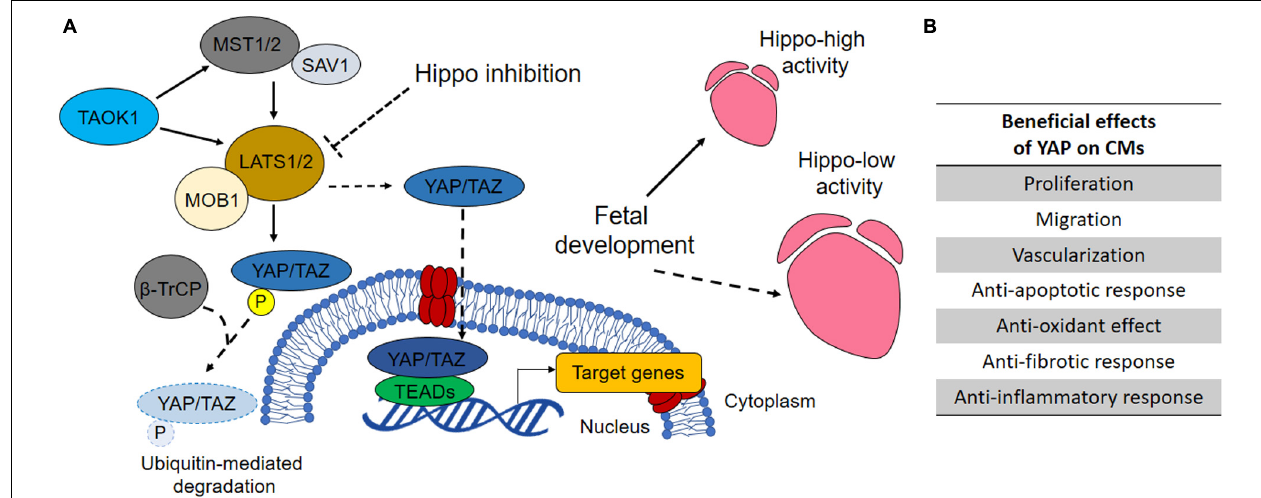
FIGURE 2 | The role of Hippo pathway in heart development and homeostasis. (A) When Hippo pathway is on, the mammalian MST1/2 (STE20-like protein kinase 1/2) and SAV1 (protein salvador homolog 1) complex activates LATS1/2 (large tumor suppressor homolog 1/2) that phosphorylates, in association with MOB1 (MOB kinase activator 1), YAP (Yes-associated protein 1) and TAZ (WW domain-containing transcription regulator protein 1), thus promoting their degradation. Conversely, when Hippo signaling is off, YAP and TAZ shuttle into the nucleus where they bind TEADs (TEA domain transcription factor family members) and regulate the transcription of genes involved in cell proliferation, survival and migration (Henry et al., 2001). By regulating the activity of YAP and consequently the proliferation of prenatal cardiomyocytes, Hippo pathway regulates heart size during development. YAP inhibitory kinase TAOK1 (TAO kinase 1) and E3 ubiquitin ligase β -TrCP ( β -transducin repeats-containing protein) are involved in YAP degradation. Their silencing has been reported to increase YAP activity in cardiomyocytes (Torrini et al., 2019). (B) Increased YAP activity has been associated with several pro-regenerative effects in developed heart to prevent cardiac diseases or promoting restoration after MI, as indicated in the table (Watt et al.,